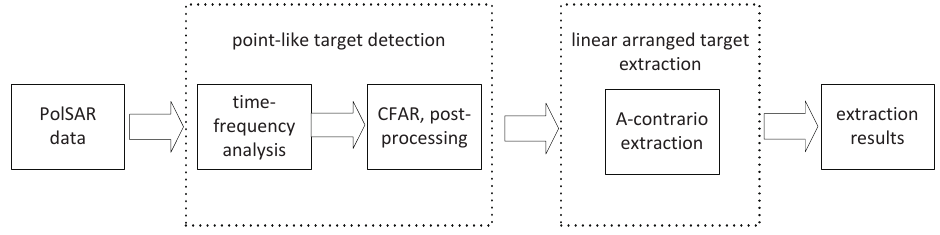
Figure 1. The block diagram of PTT target extraction from a PolSAR